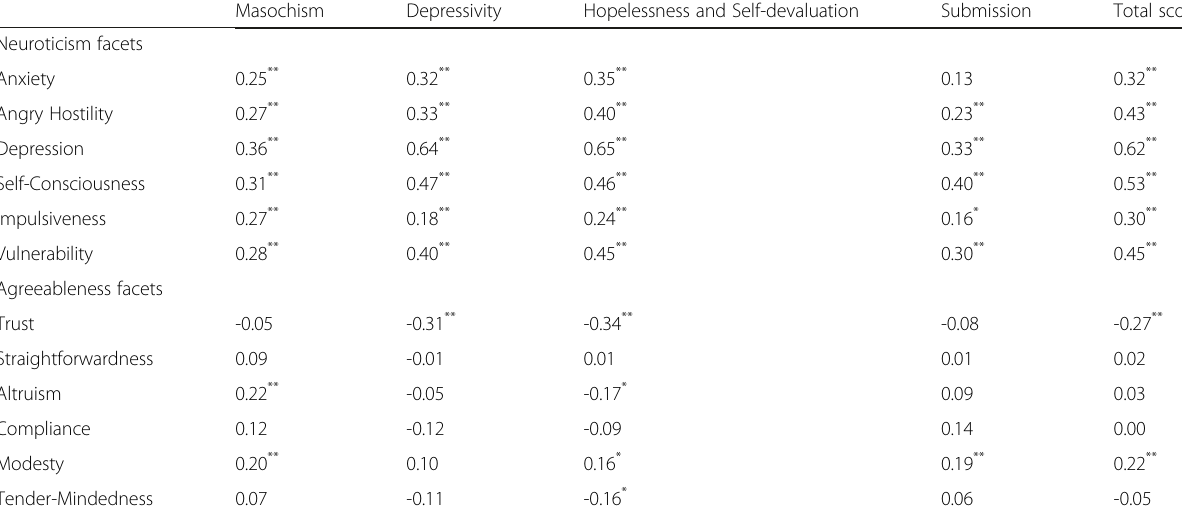
Table 3 Self-Sacrifice and Neuroticism/Agreeableness facets correlation